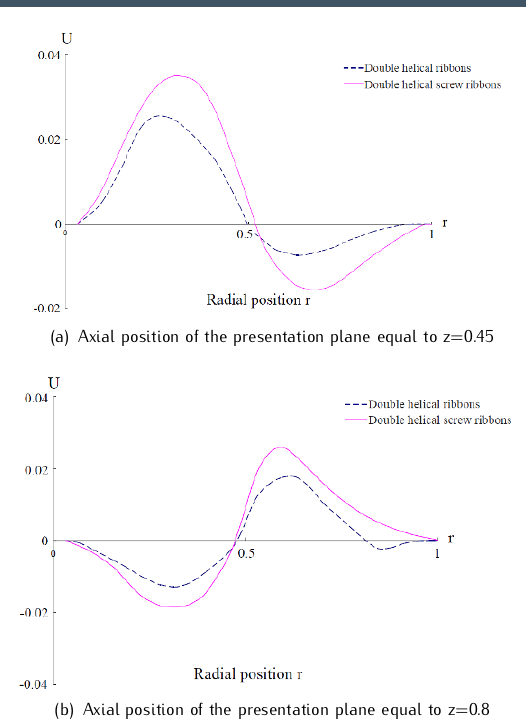
Figure 6. Radial profiles of the radial velocity U(r). Figure 7. Radial profiles of the tangential velocity V(r).